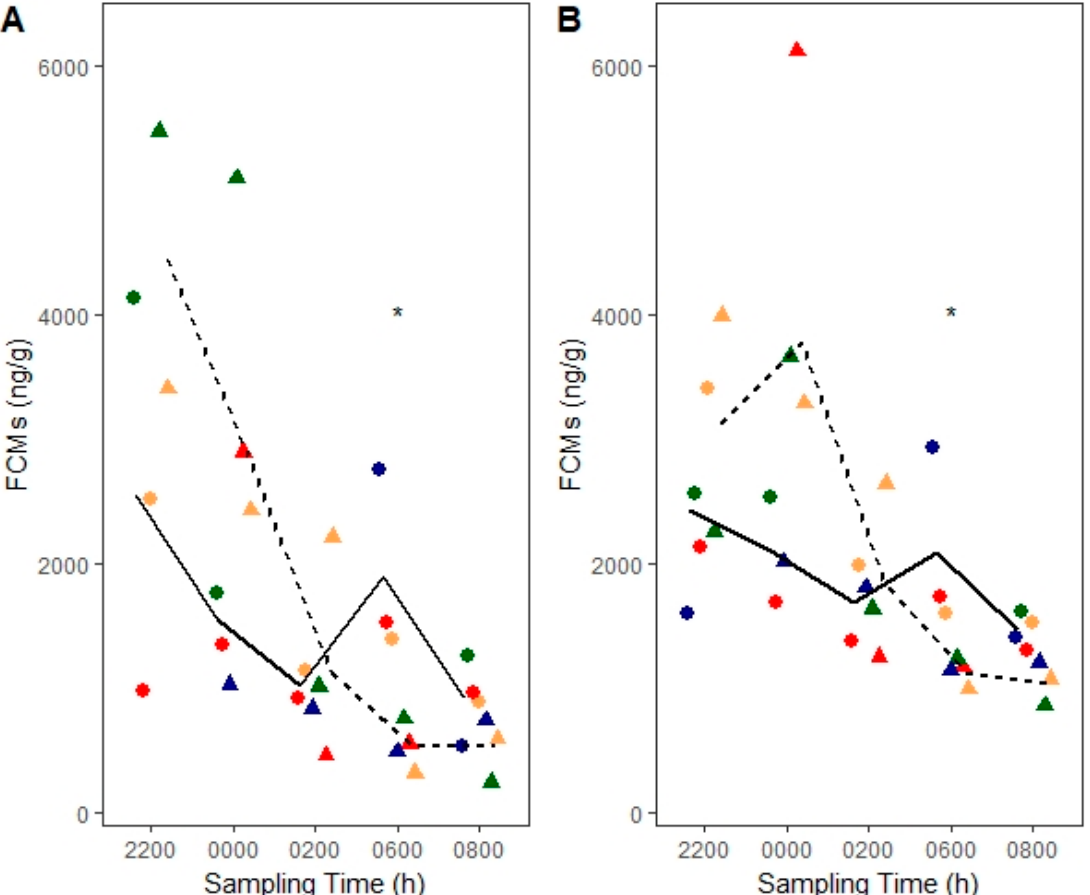
Figure 3. Corticosterone baseline fecal cortisol/corticosterone metabolites (FCMs) (solid lines and circles) versus post dexamethasone FCMs (dashed lines and triangles) in laboratory-bred deermice measured with ( A ) corticosterone enzyme immunoassay (EIA) and ( B ) group-specific EIA. Lines connect means from each sampling time. Circles and triangles indicate individual data points whereby an individual is denoted with a different color. Males are shown in blue and green colors, whereas females are shown in red and tan. Dexamethasone was administered at ~20:00 h (not shown). Asterisk (*) denotes significant differences at α = 0.05.